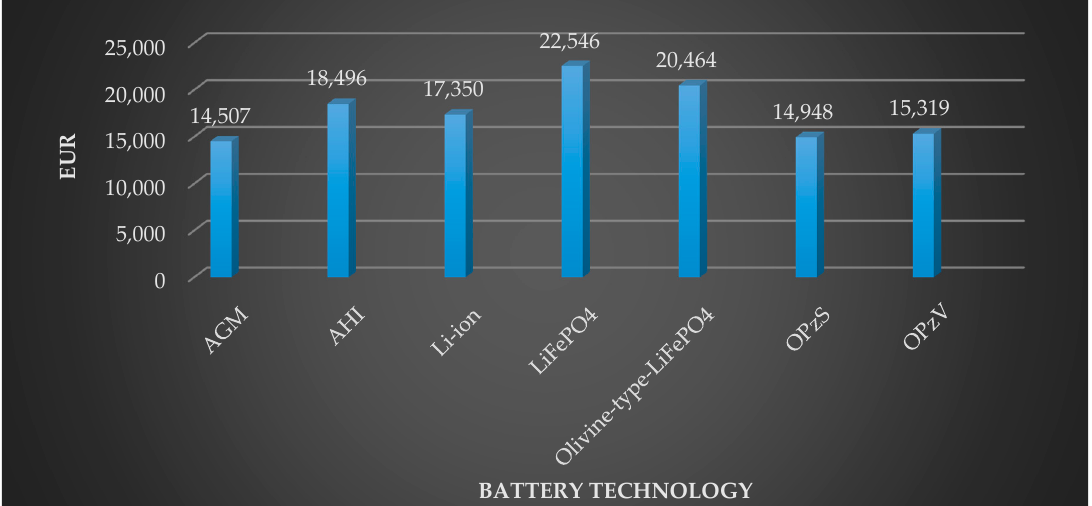
Figure 5. Total average investment costs for a complete flexible storage PV system by battery technology [59–61]. Table 2. Efficiency by flexible storage solution and the technical and economic features of selected batteries [27,41,62–83]. Energy on PV module (%) 100 System loss, PV inverter, grid